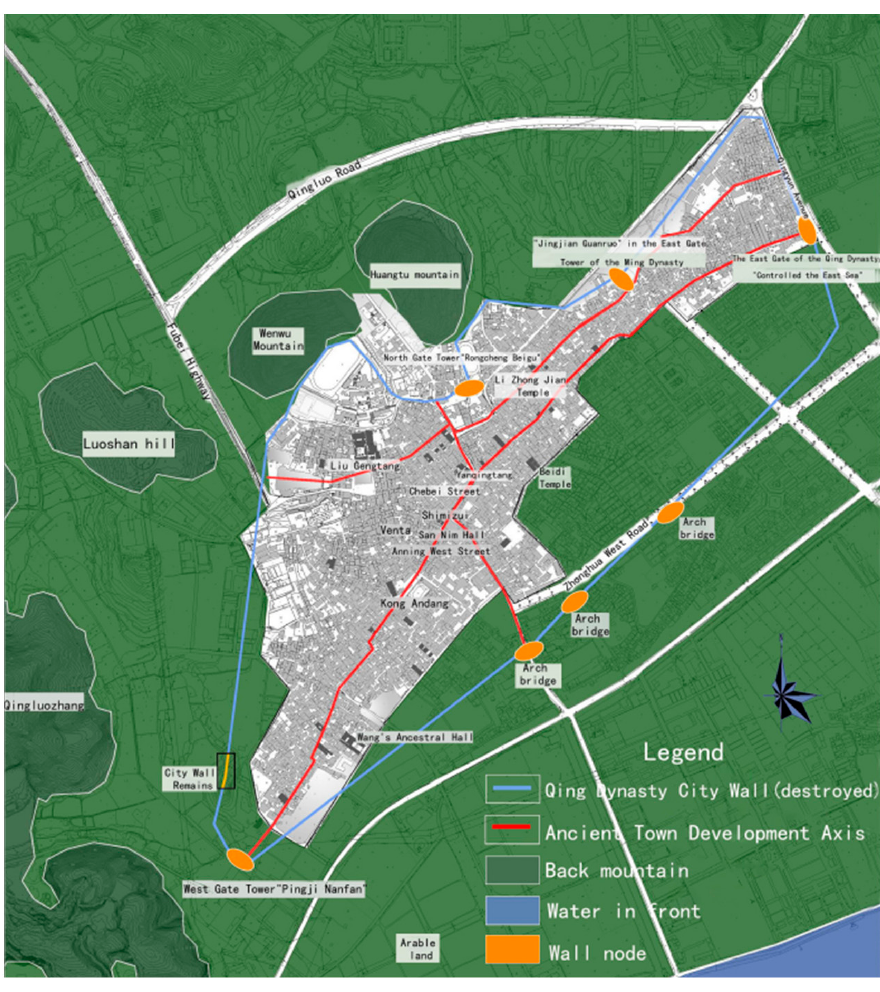
Figure 2. Analysis map of the external environment of Shawan Ancient Town. (Source: [20]).